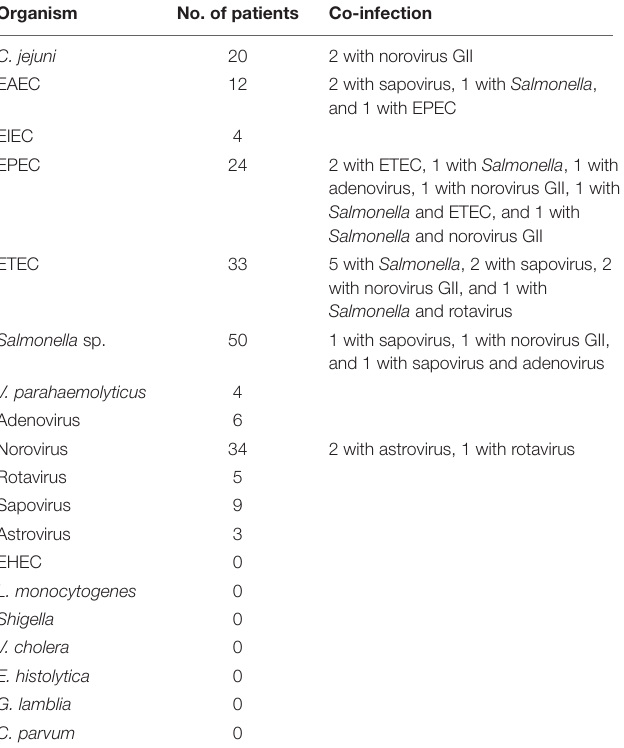
TABLE 3 | Pathogens detected in 412 tool samples isolated from the acute diarrhea patients by culture/ multiplex PCR method. Organism No. of